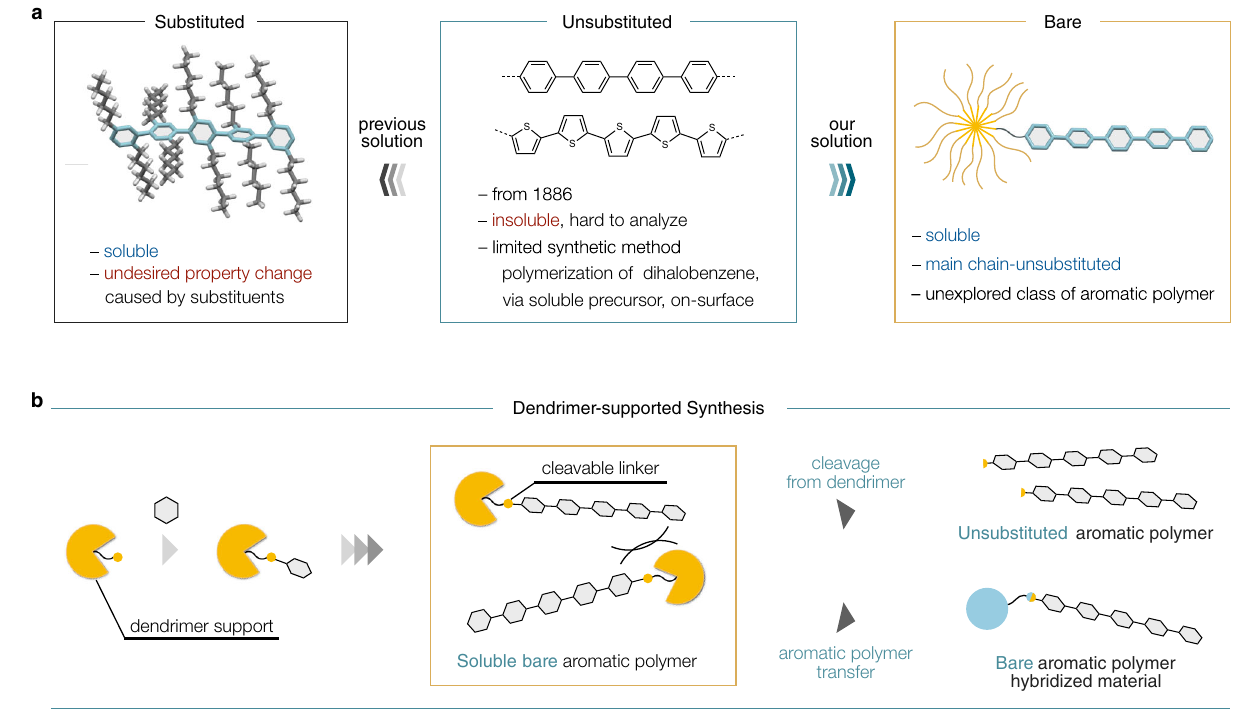
Fig. 1 | Synthesis ofbare aromaticpolymers. a Unsubstituted aromatic polymers such as poly( para -phenylene) (PPP) and polythiophene (PT) (middle); main chain- substituted aromatic polymers (left); main chain-unsubstituted bare aromatic